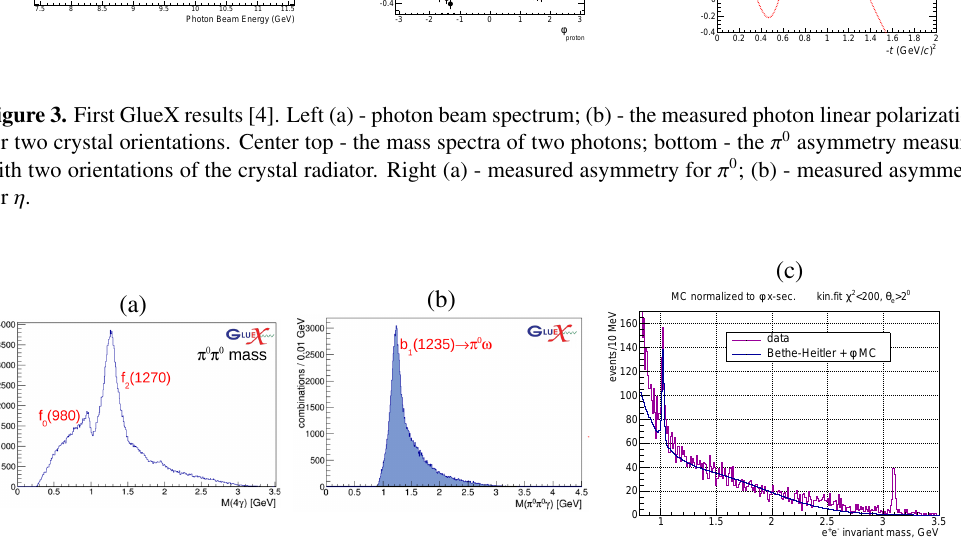
(1235) resonance 1